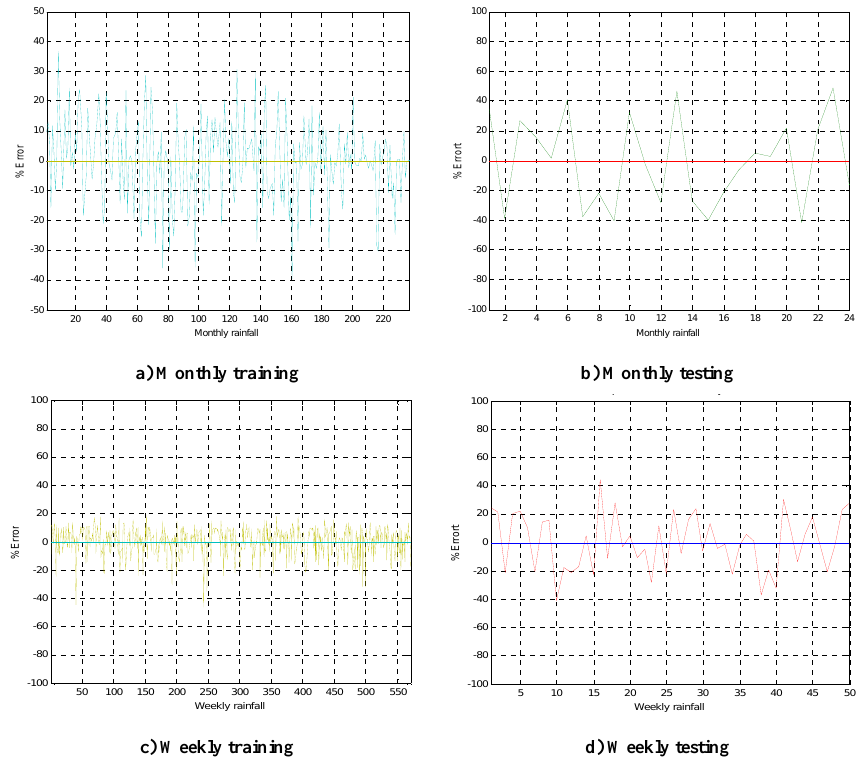
Fig. 14. Performance of the RBFNN model for monthly and weekly rainfall forecasting during training and testing stages. Table 3. RMSE and maximum RE for monthly and weekly rainfall forecasting model utilizing IDNN. RMSE Type of model